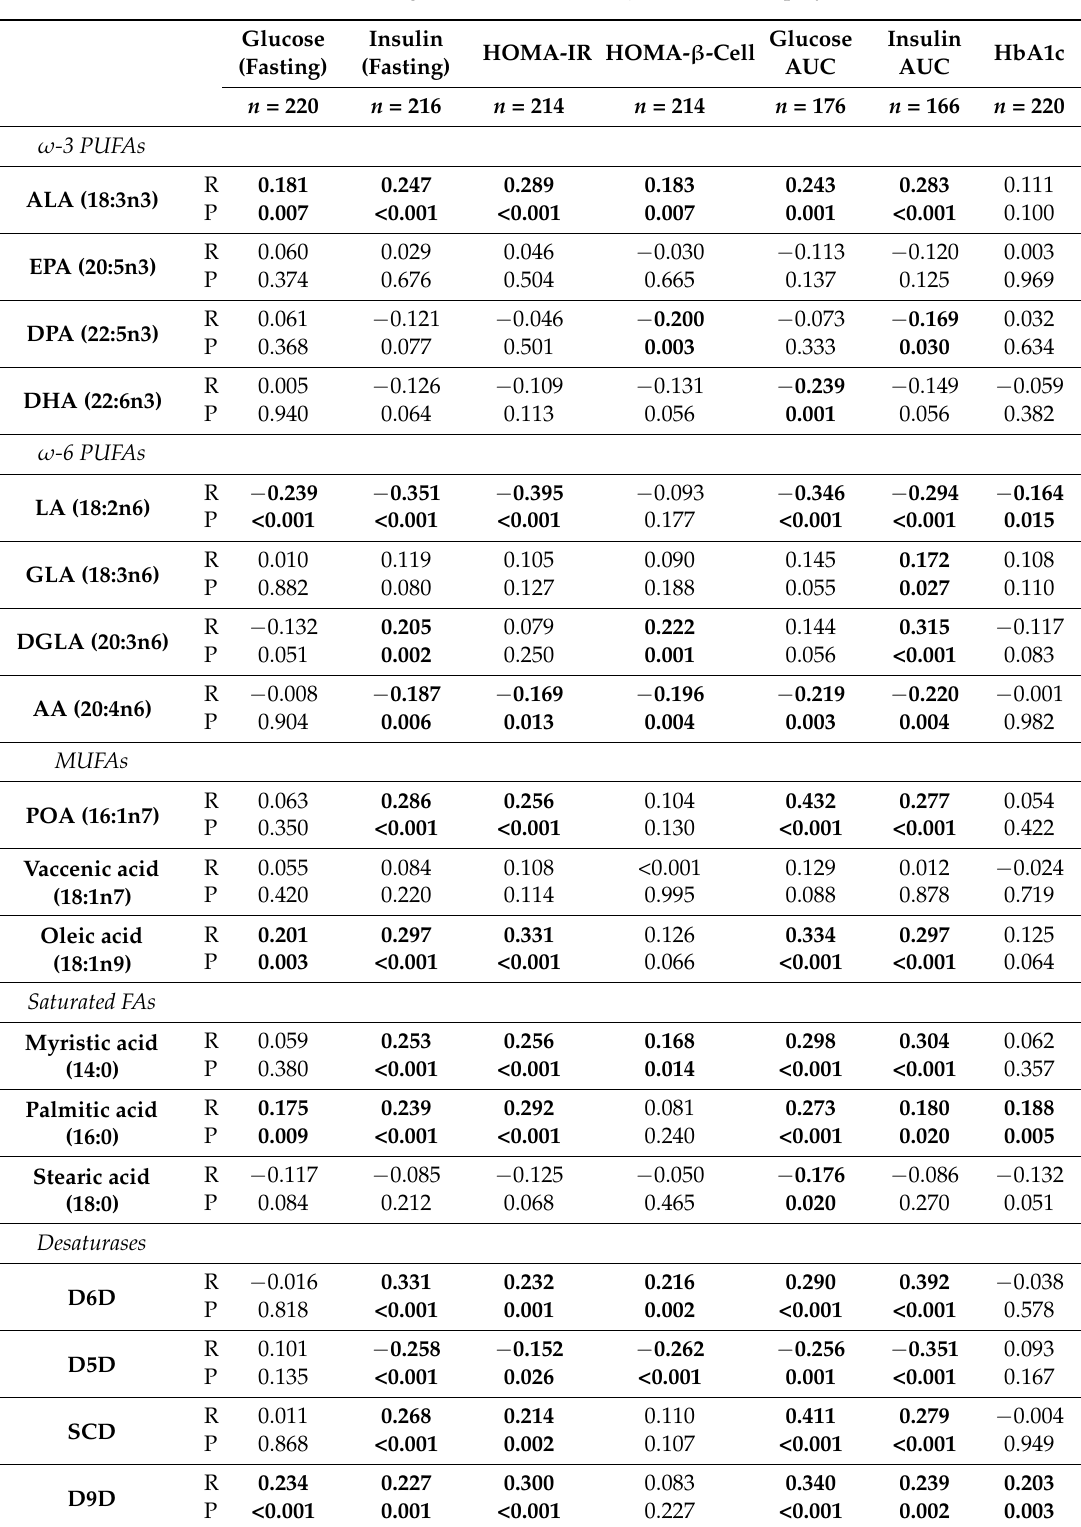
Table 5. Correlations of serum fatty acids (FAs) with glucose and insulin measurements for all women. R = Pearson correlation coefficient. Significant correlations ( p < 0.05) are displayed in